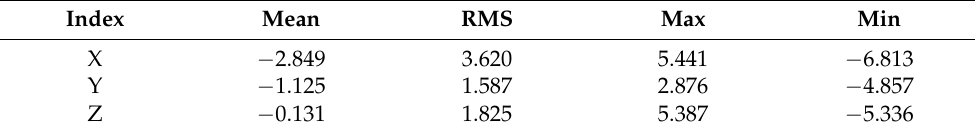
Table 10. Ground coordinates differences statistics of the corresponding image points. (Unit: meter).